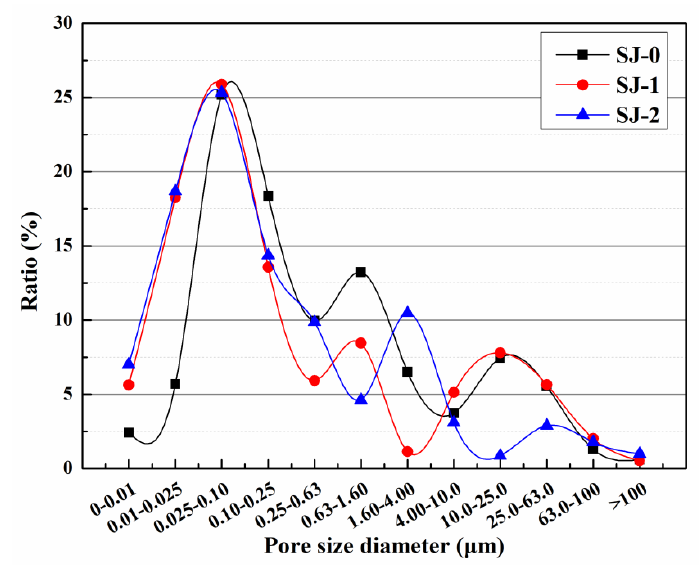
Figure 9. Pore size distribution of mortars after self-repairing.